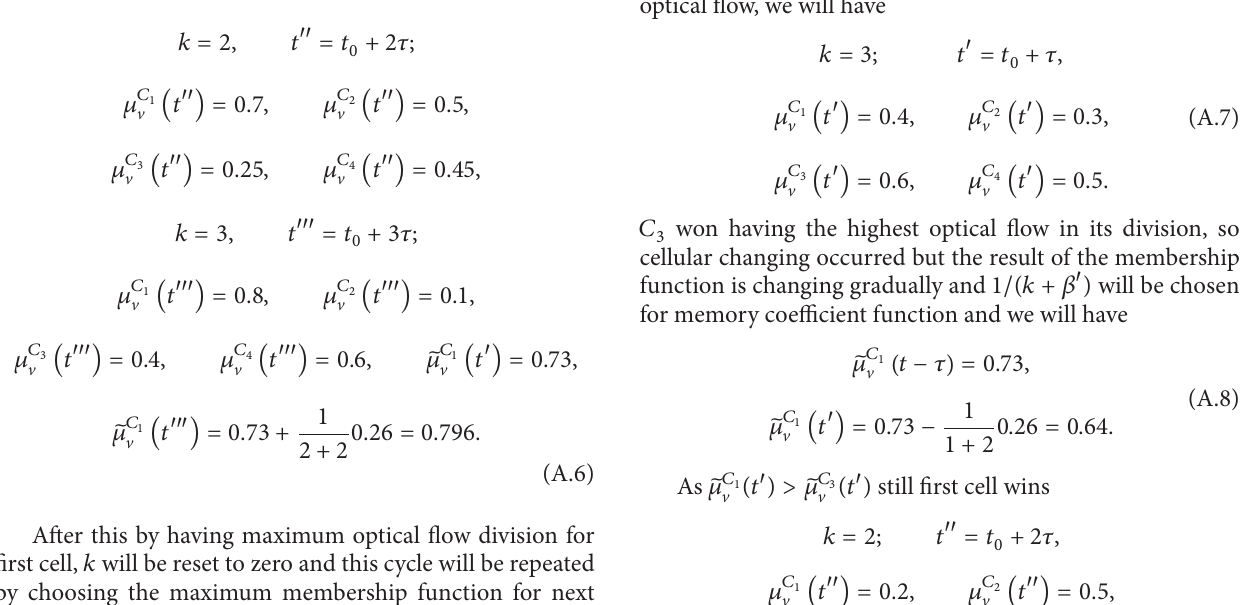
Also having 𝑁 = 3 , we will